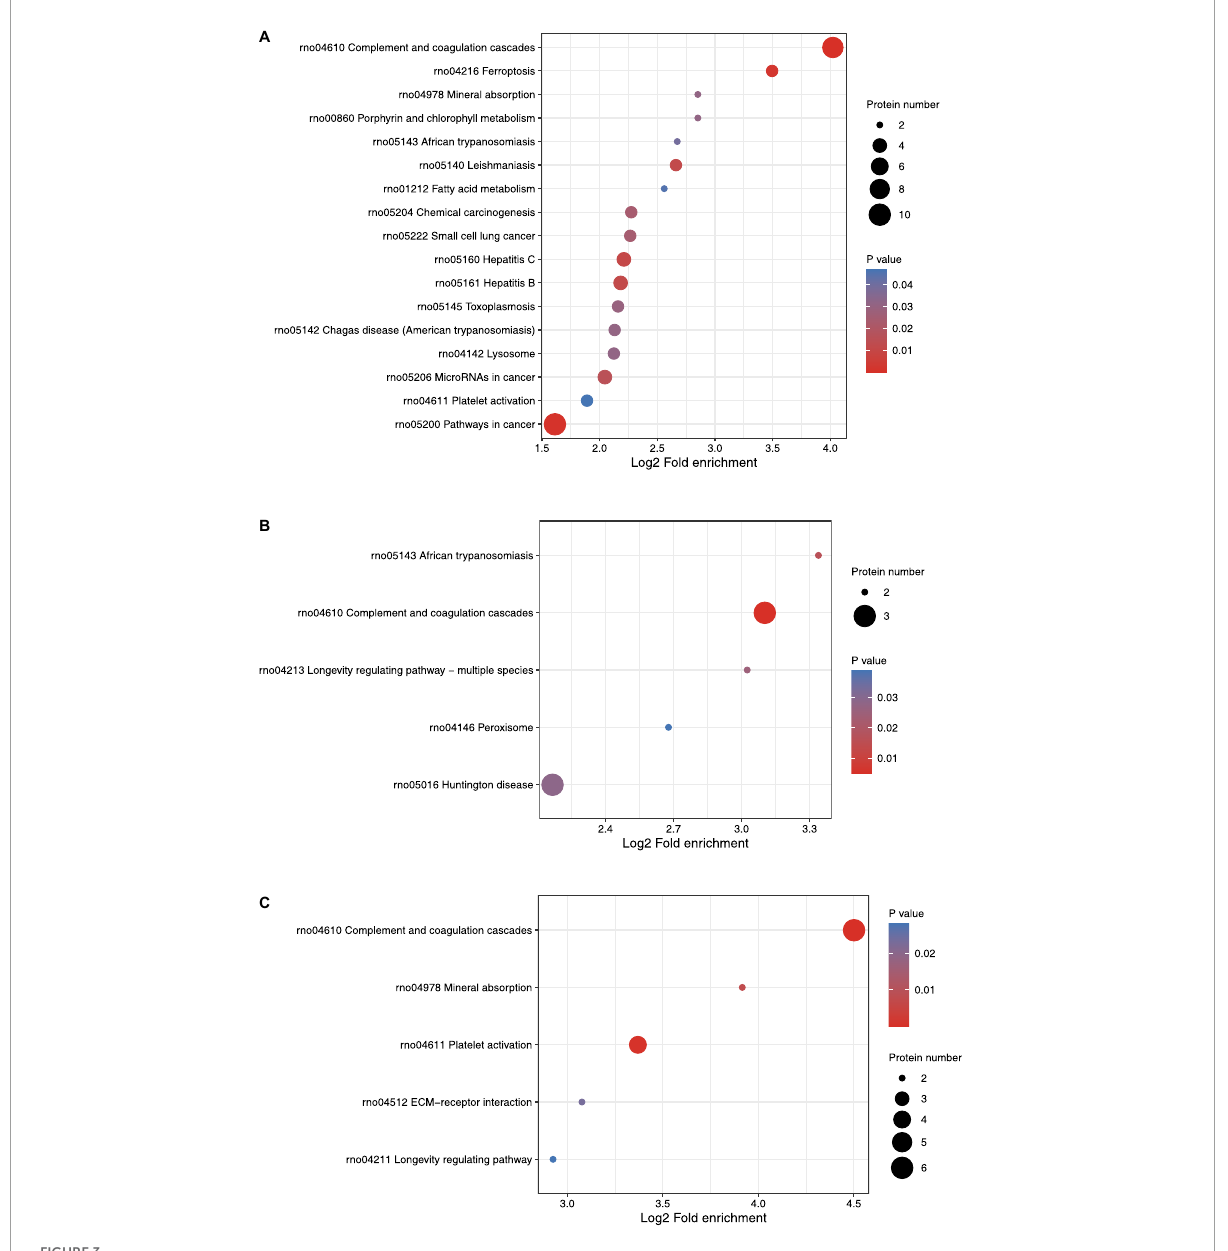
FIGURE3 KEGG function analysis of differentially expressed proteins. (A) KEGG function analysis of differentially expressed proteins on Day 1 comparing with control (ctrl) in hippocampus. (B) KEGG function analysis of differentially expressed proteins on Day 3 comparing with control (ctrl) in hippocampus. (C) KEGG function analysis of differentially expressed proteins on Day 3 comparing with Day 1 in